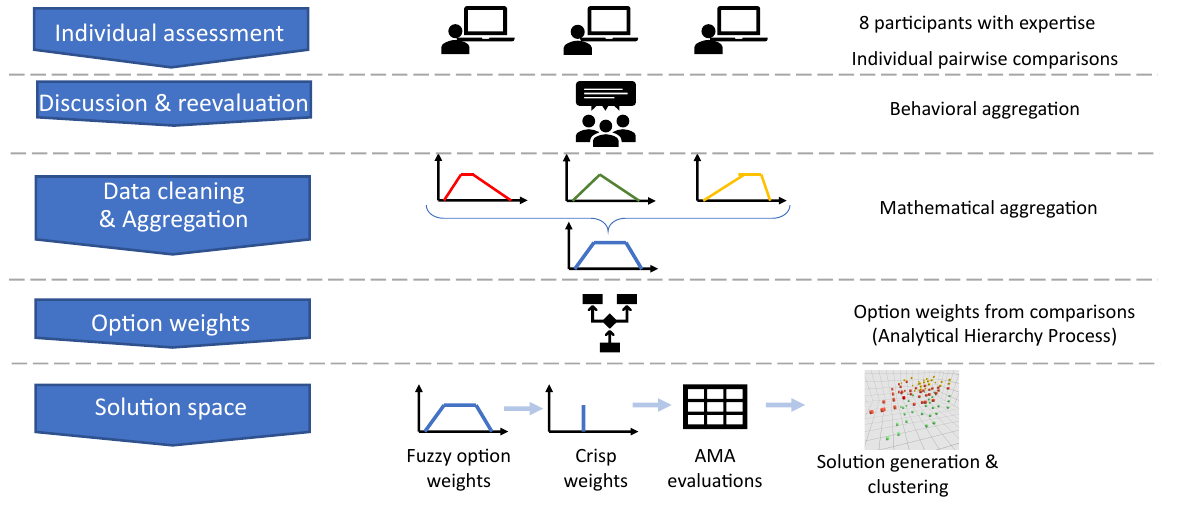
Figure 7. Schematic steps of the data